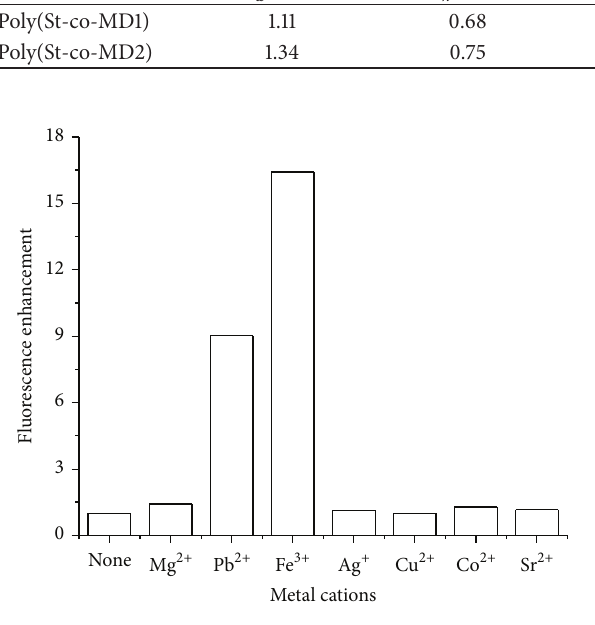
Figure 2: Effect of the metal cations at concentration 𝑐 = 10 −5 molL −1 on the fluorescence of MD1 in acetonitrile solution.